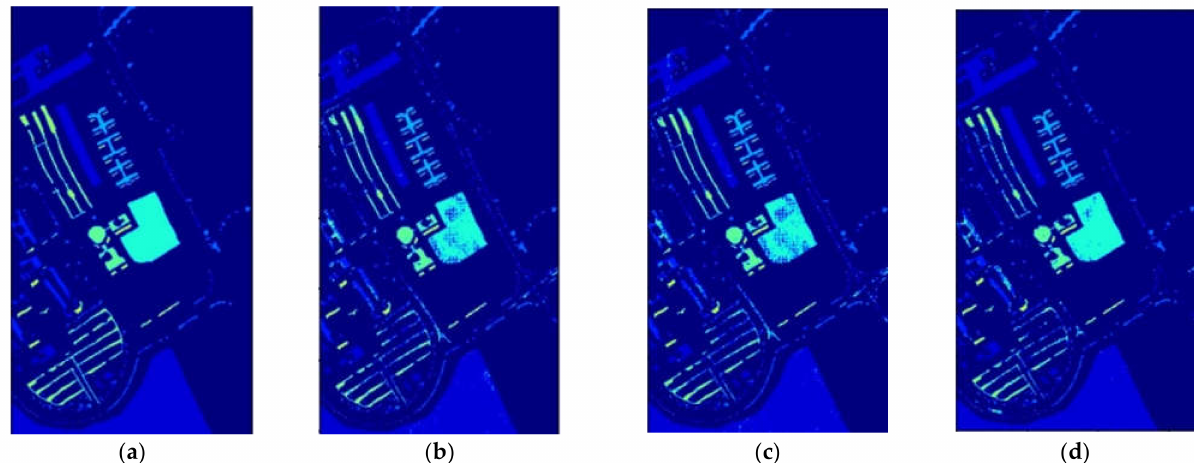
Figure 16. Classification maps obtained for the Pavia University dataset with a controlled sampling strategy based on w3 window size for the training set, for N = 1 wavelet transform level and LBP riu2 ( a ) reference map, ( b ) TV filtering, ( c ) CSSWHTV filtering, ( d ) anisotropic diffusion and shock filter-based